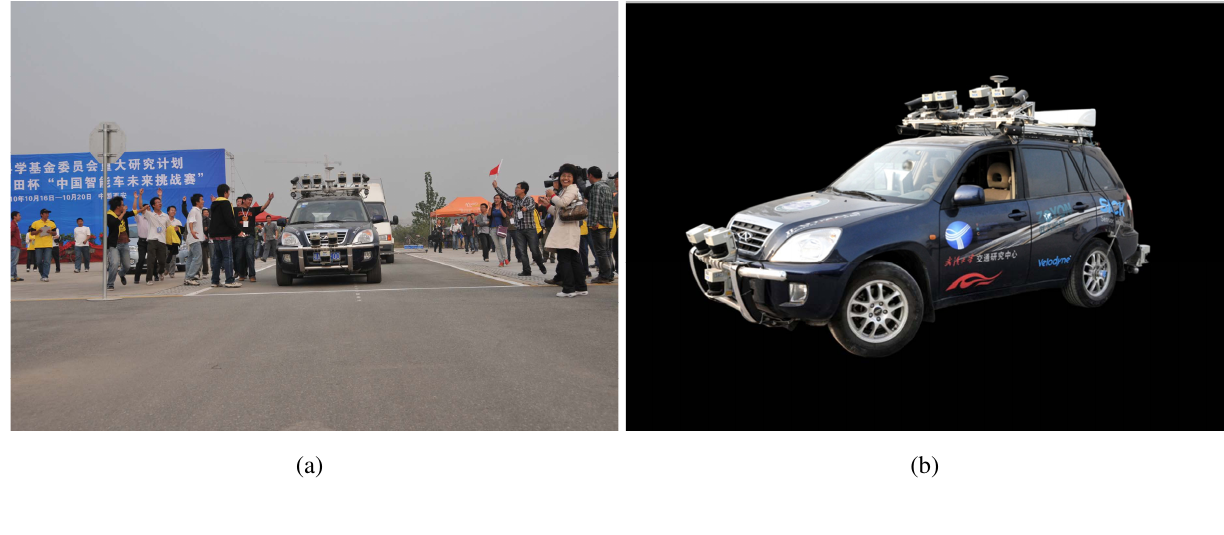
Figure 1. ( a ) At approximately 3:04 pm on Oct 18, 2010, SmartV-II was the first robot